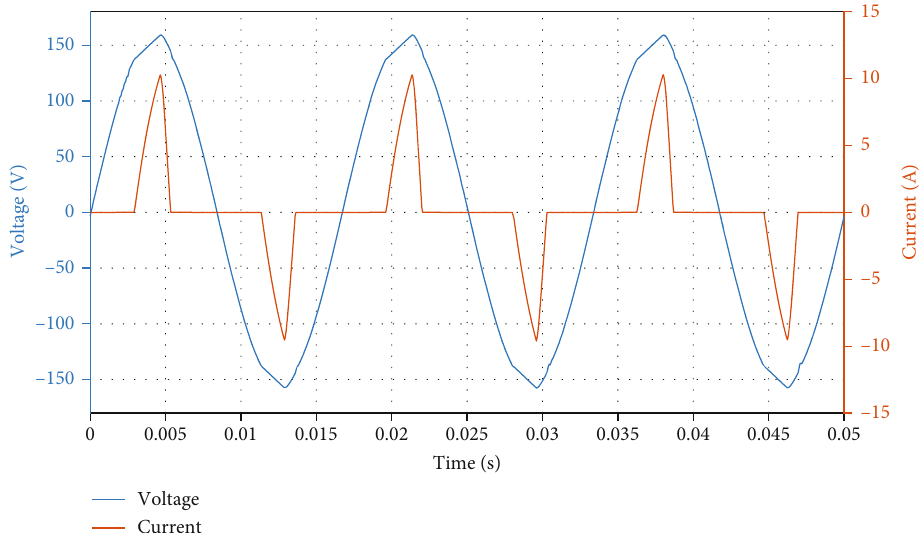
Figure 17: Nonlinear load simulation results. V